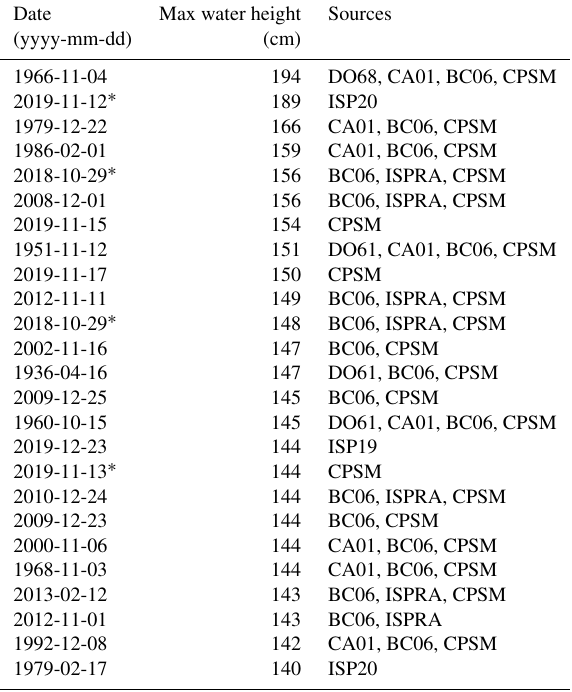
Table A1. List of the events higher than 100cm alongside the respective water height maxima. AN41: Annali, 1941; CA01: Canestrelli et al., 2001; CA19: Cavaleri et al., 2019; CA20: Cav- aleri et al., 2020; CPSM: CPSM, 2019; DE06: de Zolt et